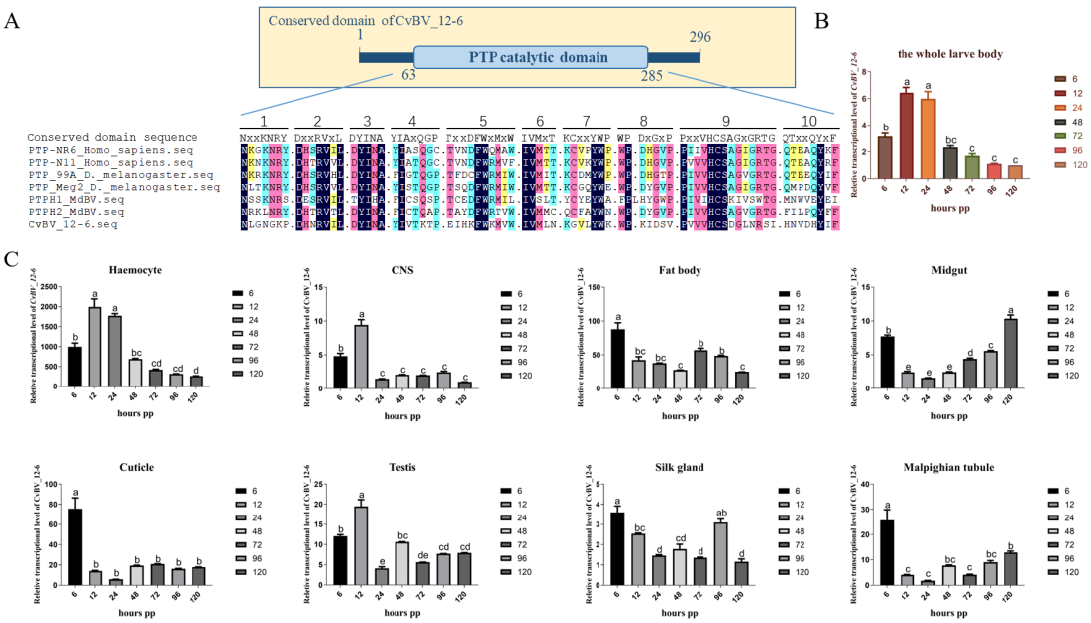
Figure 1. The conserved motifs and expression patterns of CvBV_12-6 . ( A ) Image showing the conserved domain in the CvBV_12-6 protein and the amino acid sequence of each motif. X represents any amino acid. Conserved domain sequence: PTP NR6 and PTP N11 were from Homo sapiens ; PTP_meg2 and PTP_99A were from D. melanogaster ; PTP H1 and PTP H2 were from MdBV. ( B ) The transcriptional dynamics of CvBV_12-6 in P. xylostella 6, 12, 24, 48, 72, 96, and 120 h post parasitiza- tion (pp). ( C ) The expression pattern of CvBV_12-6 in different tissues of parasitized P. xylostella. Data are presented as the mean ± SD based on three independent experiments. Differences among samples were tested via Tukey’s test, a nd different letters indicate significant differences at a p value < 0.05.